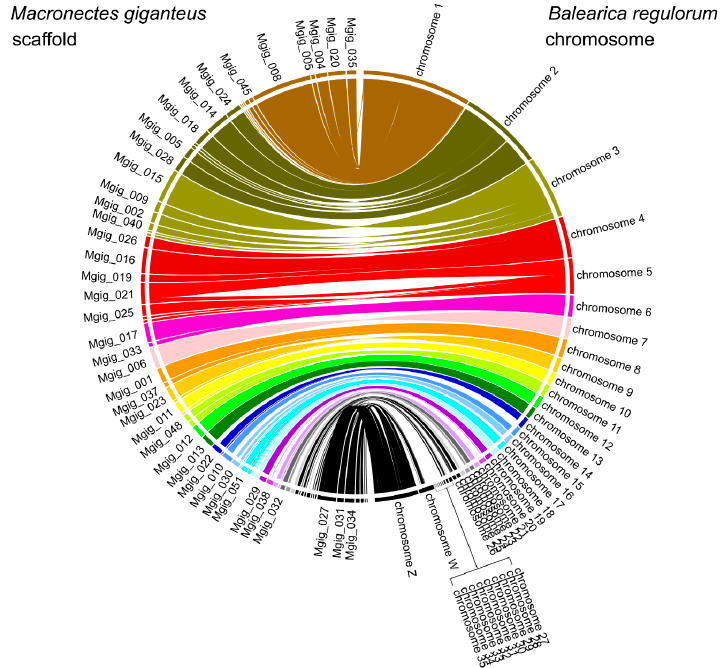
Figure 2. Collinear relationship between Macronectes giganteus and Balearica regulorum . Lines be- tween the two rectangles show the shared syntenic blocks between the chromosomes, based on se- quence homology.